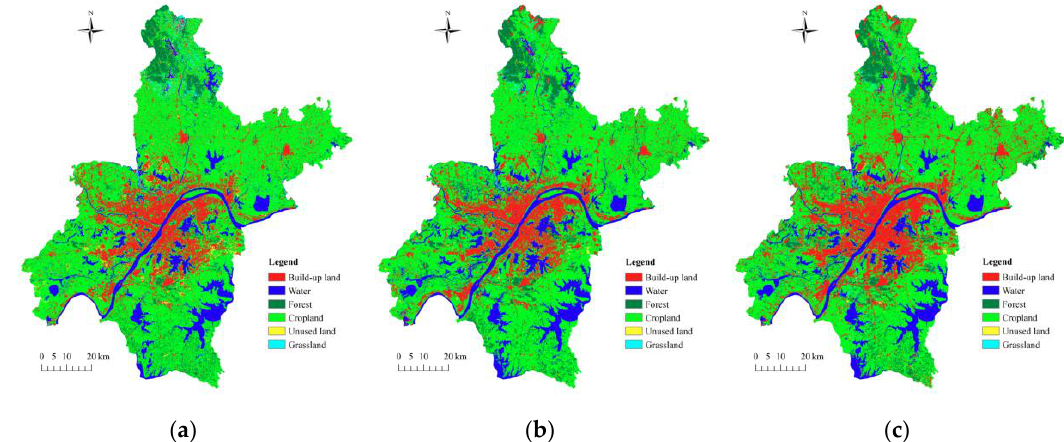
Figure 14. The LULC simulation results of Wuhan: ( a ) the reference LULC map in 2019; ( b ) the simulated LULC result in 2019; ( c ) the simulated LULC result in 2029.